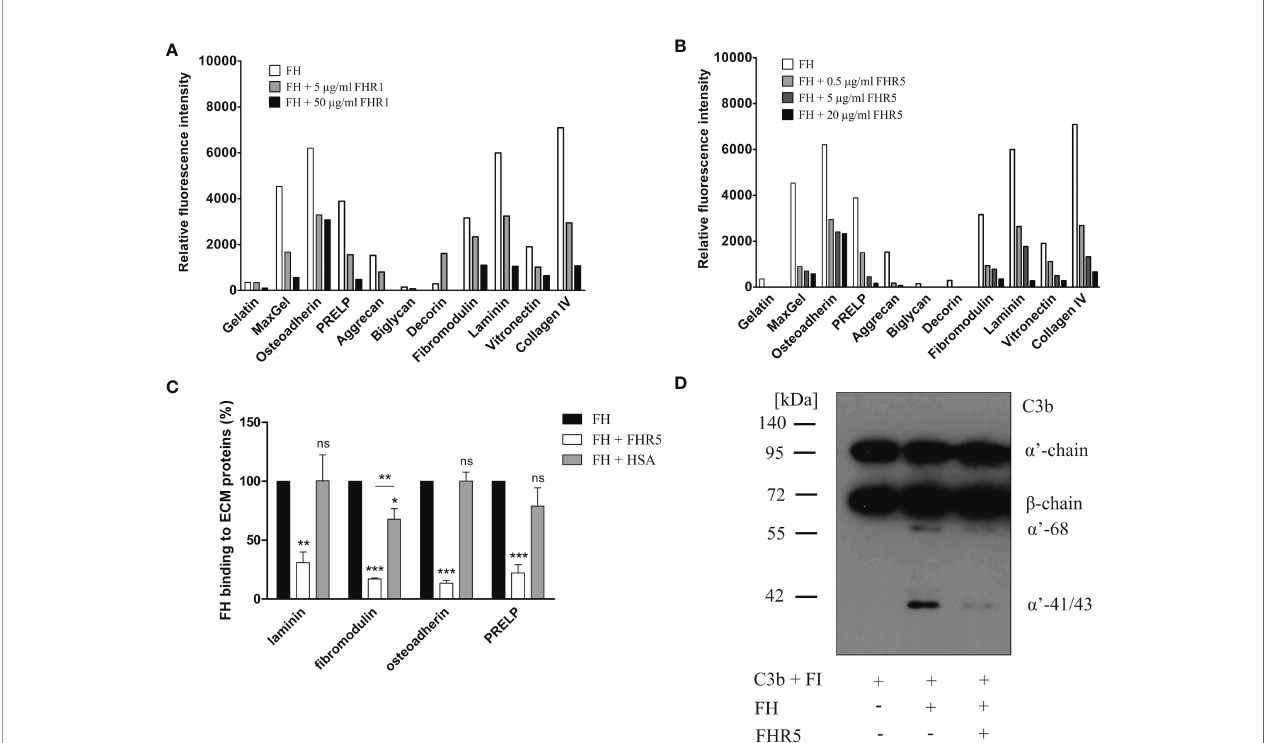
FIGURE 4 | FHR1 and FHR5 compete with FH for binding to several ECM components, and FHR5 competitively inhibits the cofactor activity of FH. ECM proteins were printed on slides and incubated with 25 µg/ml FH together with increasing concentrations of FHR1 (A) or FHR5 (B) . Binding of FH was measured by monoclonal mouse anti-FH (A254) that does not recognize FHR1 or FHR5 and Alexa546-conjugated goat anti-mouse IgG. Data are representative of two experiments. (C) Competition between FHR5 and FH was also measured in ELISA. Laminin, fi bromodulin, osteoadherin and PRELP (10 µg/ml of each) were immobilized and incubated with 50 µg/ml FH with or without 20 µg/ml FHR5. FH binding to ECM proteins was detected as described earlier. The values were normalized for FH binding (100%) and show means ± SD derived from three independent experiments. *p <0.05, **p <0.01, ***p <0.001, one-way ANOVA; ns, not signi fi cant. (D) Laminin (10 µg/ml) was immobilized and after blocking, the wells were incubated with 100 µg/ml FH with or without 20 µg/ml FHR5. Then, 140 nM C3b and 220 nM FI were added to the wells for one hour at 37°C. After incubation, supernatants were analyzed on 7.5% SDS-PAGE and Western blot. The blot was developed by using HRP-conjugated anti-human C3 Ab that recognizes C3b and its fragments except for C3d. The molecular mass marker is indicated on the left, and the C3b chains and the C3b a ’ -chain cleavage fragments are indicated on the right. Results are representative of three